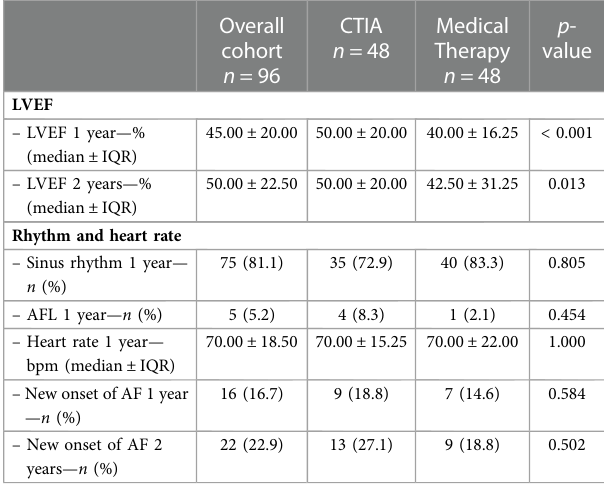
TABLE 2 Characteristics of overall cohort and different study groups (CTIA group vs. medical therapy group) concerning 1 and 2 year follow-